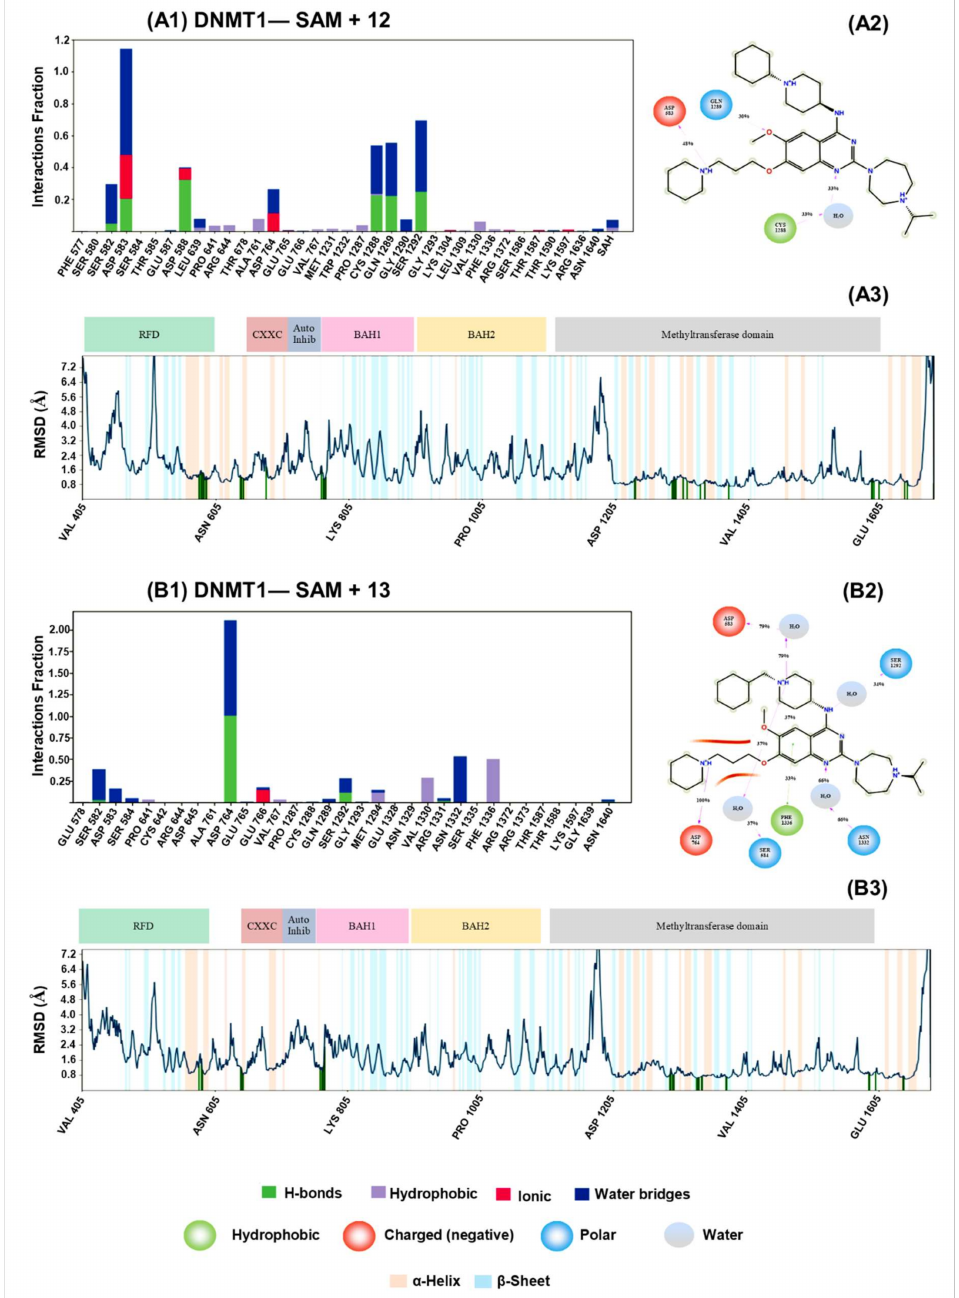
Figure 3. Molecular dynamic results of compounds 12 and 13 against DNMT1. 300 ns were produced peer each compound. The ( A1 , B1 ) panels show the interactions between ligands and the DNMT1 structure in the presence of S -adenosyl- L -methionine (SAM). Additionally, panels ( A2 , B2 ) show the representative key interaction during the last 30 ns of molecular dynamic productions. Finally, panels ( A3 , B3 ) illustrate the conformational changes (RMSD values) on different key domains on